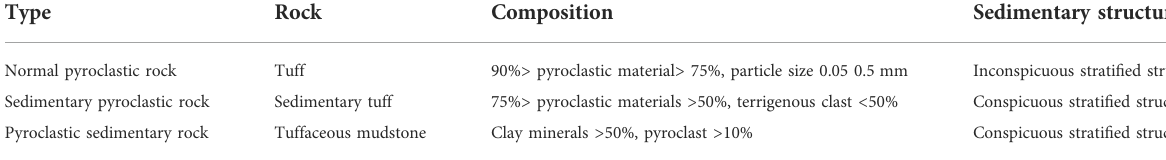
TABLE 1 Classi fi cation of permian tuffaceous section in the sichuan